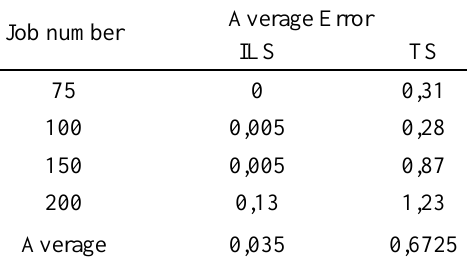
Table 7. Average error according to job